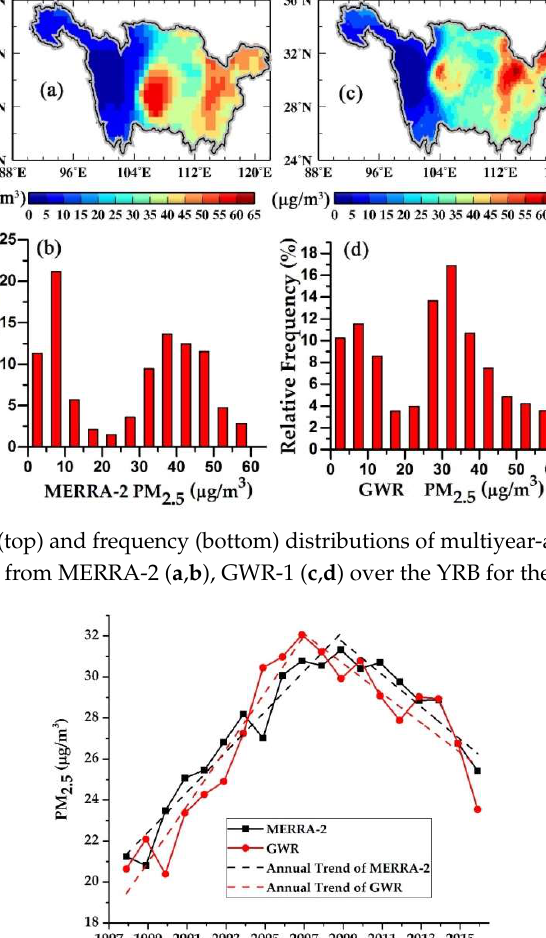
Figure A1. Scatter plot between GWR and ground-based annual mean PM 2.5 concentrations derived from 476 air quality monitoring stations of the YRB for the period of Jan. 2015 – Dec. 2016. The black line is a 1:1 line and the red line is a linear fit line.